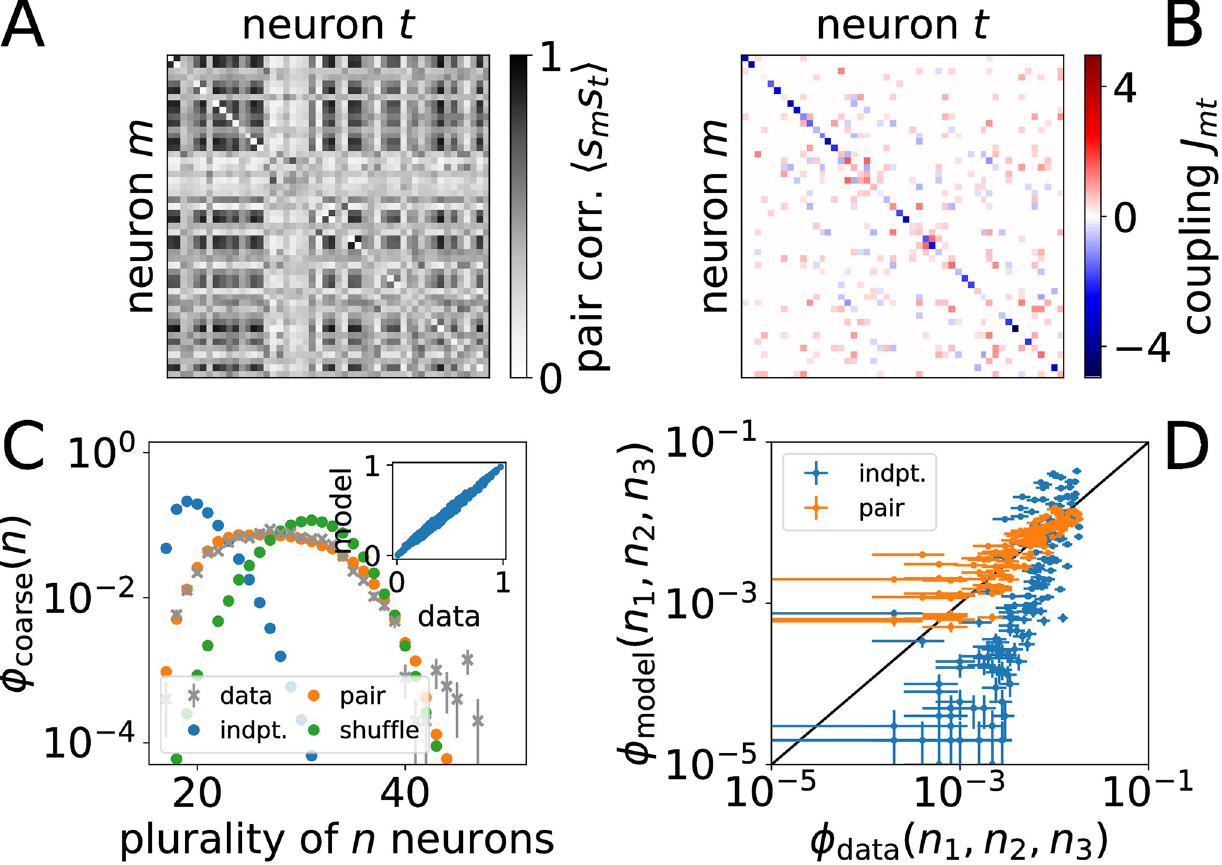
Fig 2. Pairwise maxent model of anterior neural activity from reference [59] (see Fig B in S1 Text for another experiment). (A) Pairwise correlations between subset of N = 50 neurons. Average individual neuron r k = − 1 ( s m ) shown along diagonal. (B) Inferred biases h m , k = − 1 along diagonal and matrix of couplings J off the diagonal. (C) Coarse collective synchrony, probability that a plurality of n neurons coincide ϕ coarse ( n ), for data, pairwise maxent model, mt independent model, and shuffled couplings. Inset compares pairwise correlations for data with maxent model. Error bars show one standard deviation over bootstrapped samples. (D) Fine-grained synchrony ϕ fine in the independent vs. pairwise maxent model. This is the probability of set sizes, the number of neurons in each of the three states when ordered n 1 � n 2 � n 3 such that n 1 corresponds to the size of the plurality and n 3 the smaller minority. Error bars show one standard